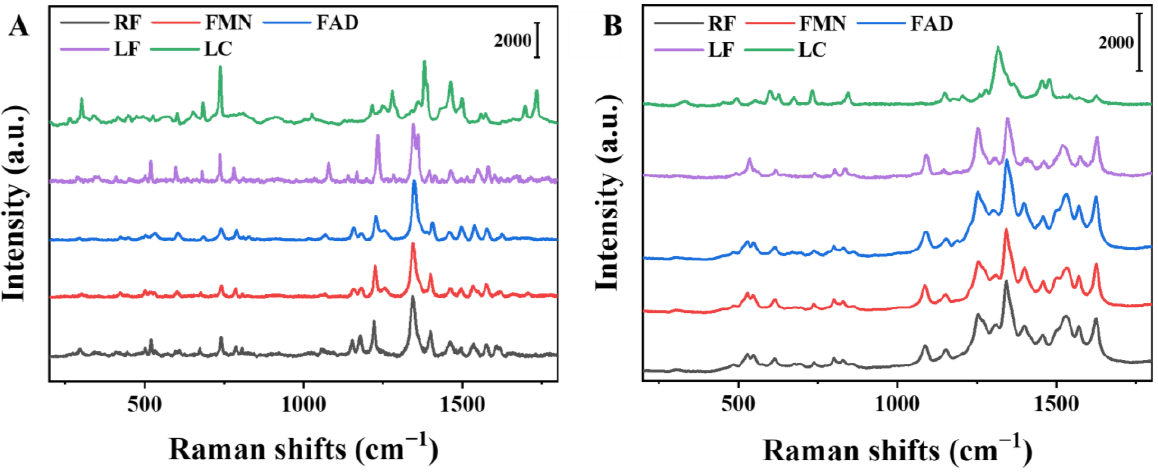
Figure 2. Normal Raman ( A ) and SERS ( B ) spectra of LC, LF, FAD, FMN, and